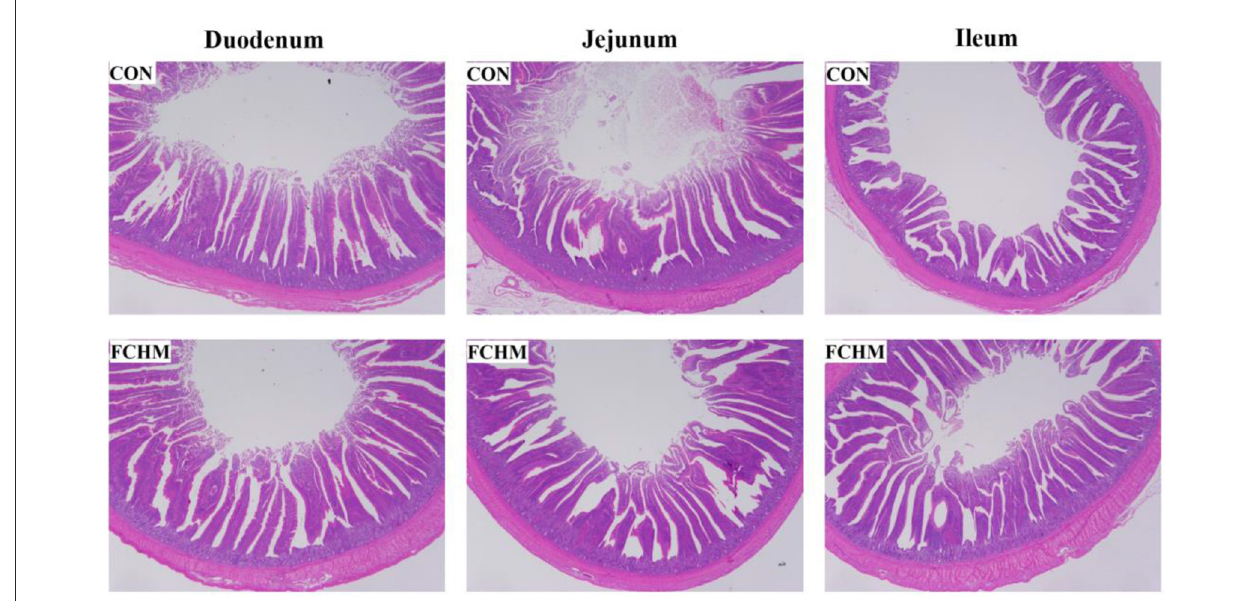
FIGURE1 The morphologic structures of the gut (duodenum, jejunum, and ileum) of broiler chickens on day 42. The photos were viewed under 20 × magnification. CON, control group, fed essential diet; FCHM, 5% FCHM replacement group.